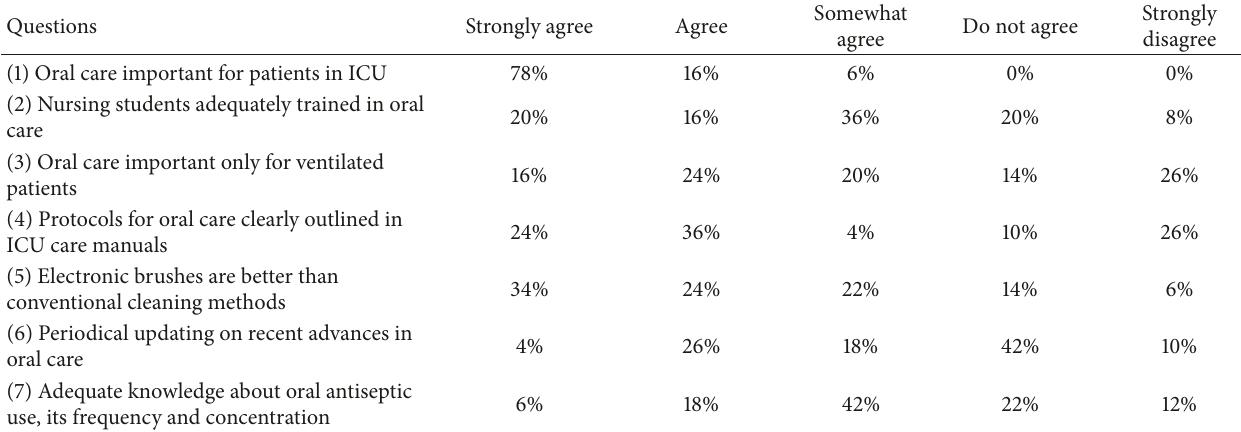
Table 1: Assessment of knowledge regarding oral care in ICU setting.